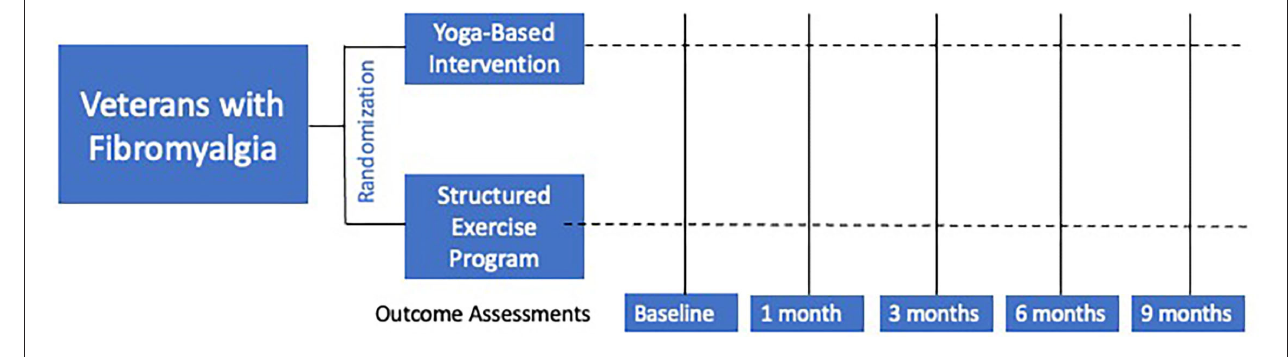
FIGURE 1 | Overall study